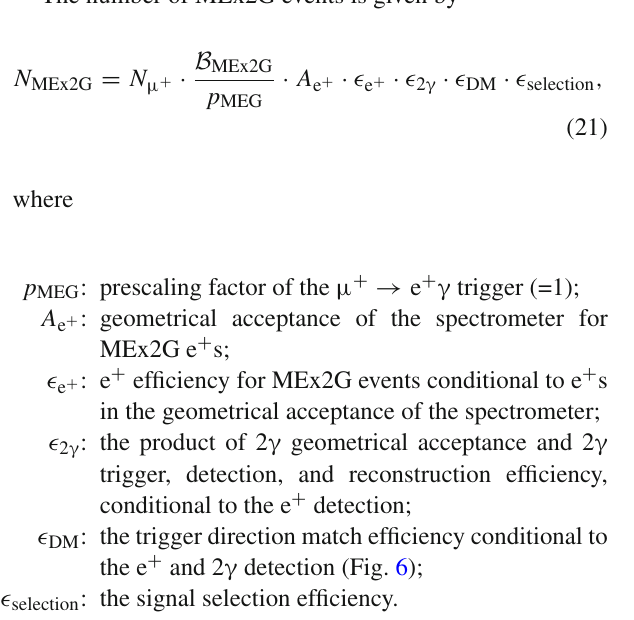
Fig. 14 Distributions of variables used in the event selection for ( m ,τ ) = (20 MeV/c 2 , 20 ps) case. The hatched histograms show X X the distribution of MC signal events while the blank histograms that of background events; each histogram is normalised to 1. The vertical lines show the optimised thresholds. a The peak value of the signal